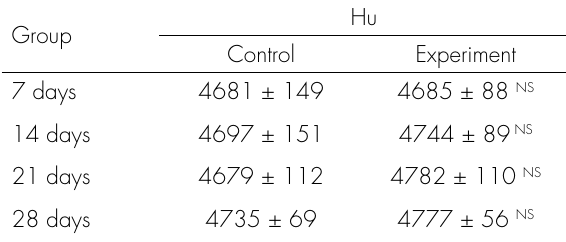
Table III. Bone mineral density in the experimental and control groups.